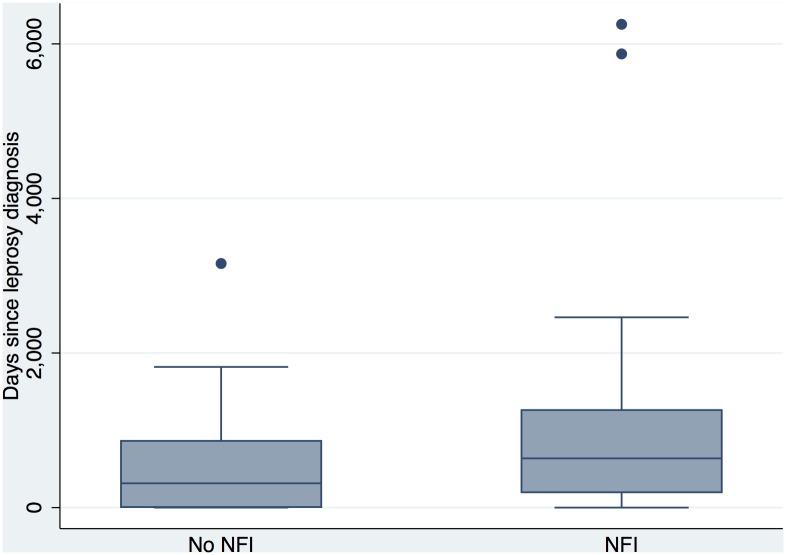
Duration of ENL and presence of nerve function impairment (NFI).